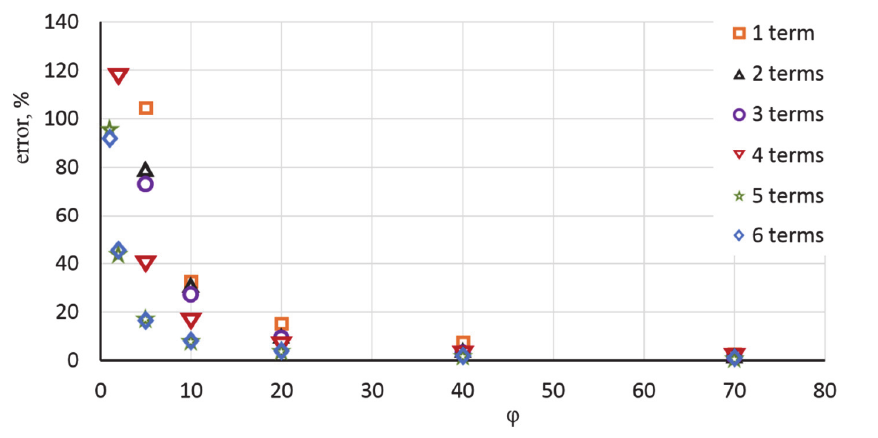
Figure 6: Effect of the level of over-determination (i.e. φ parameter, as defined in Eq.